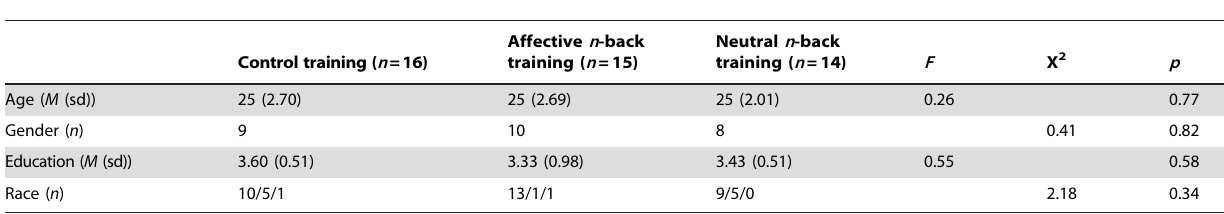
Table 1. Group demographic